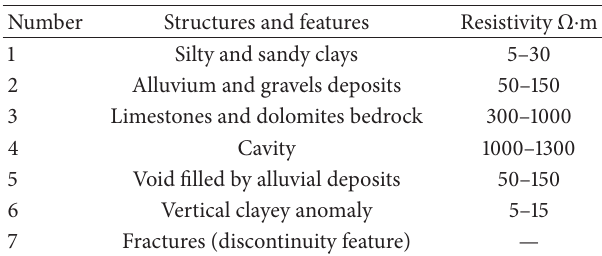
Block II . This block forms the central part of the ERT-P1 profile coinciding with the main valley course and stretching over a distance interval of 300 to 500 m measured from the ERT section start point (Figure 4). The 200 m long block is sharply limited by two abrupt vertical edges,